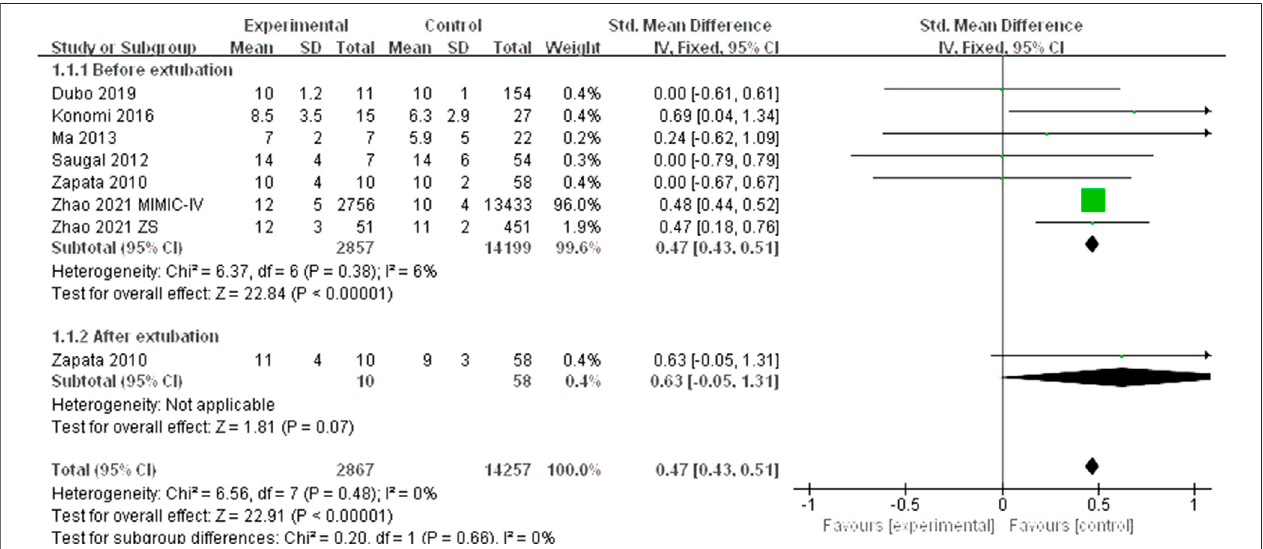
FIGURE 2 | The CVP levels standard mean difference between extubation failure and extubation success groups.